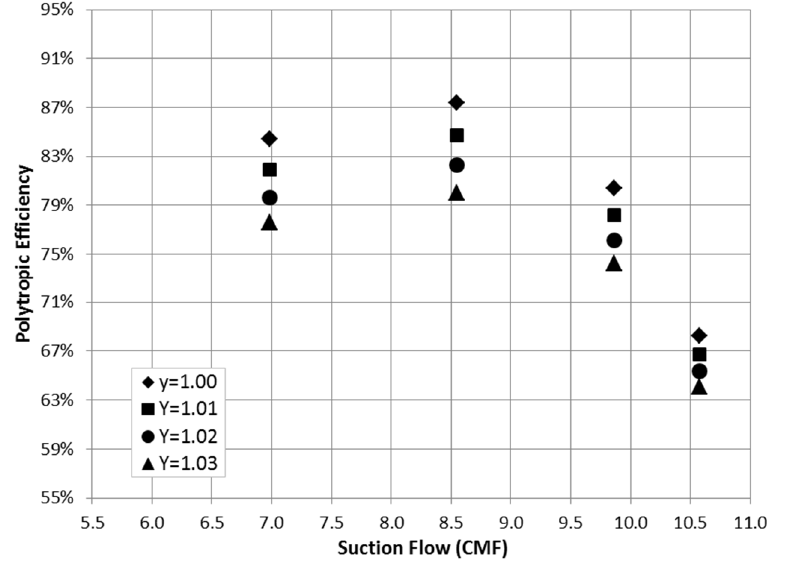
Figure 2. Effect of compressibility function ( Y ) on polytropic